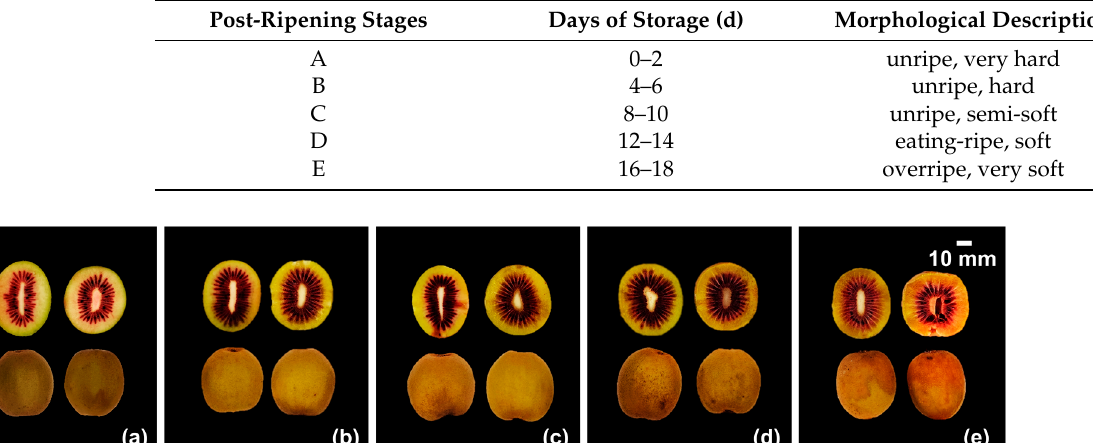
Table 1. The division principle of 5 post-ripening stages.